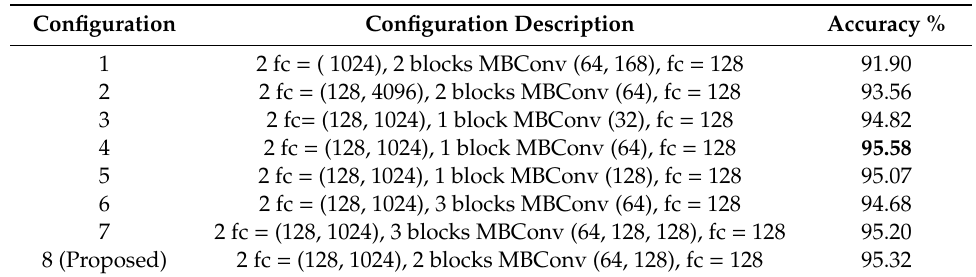
Table 8. Classification accuracy of 2D-CNN network by applying three di ff erent configurations for ECG